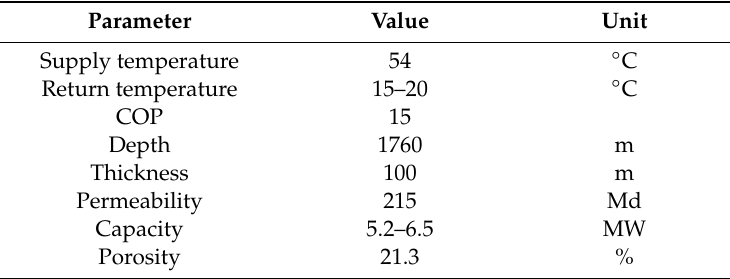
Table 1 . Geothermal source production characteristics. Retrieved from van Campenhout [29].